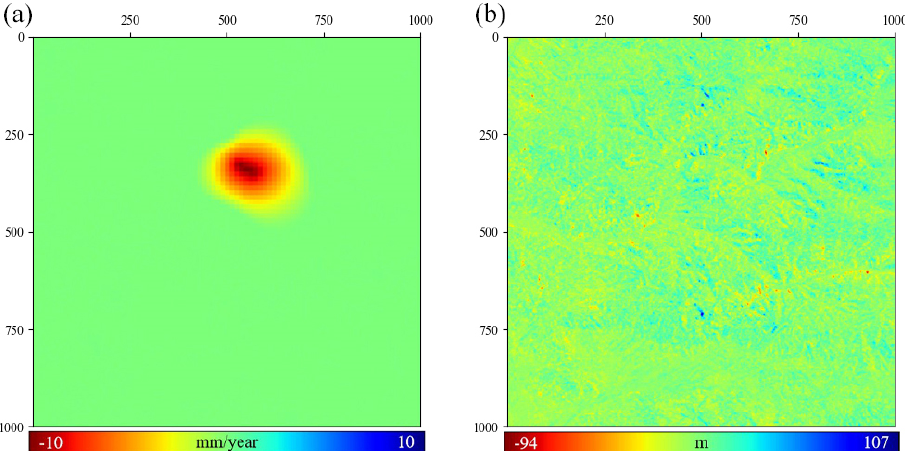
Figure 2. Simulated data. ( a ) Simulated deformation data and ( b ) simulated DEM residual error data.